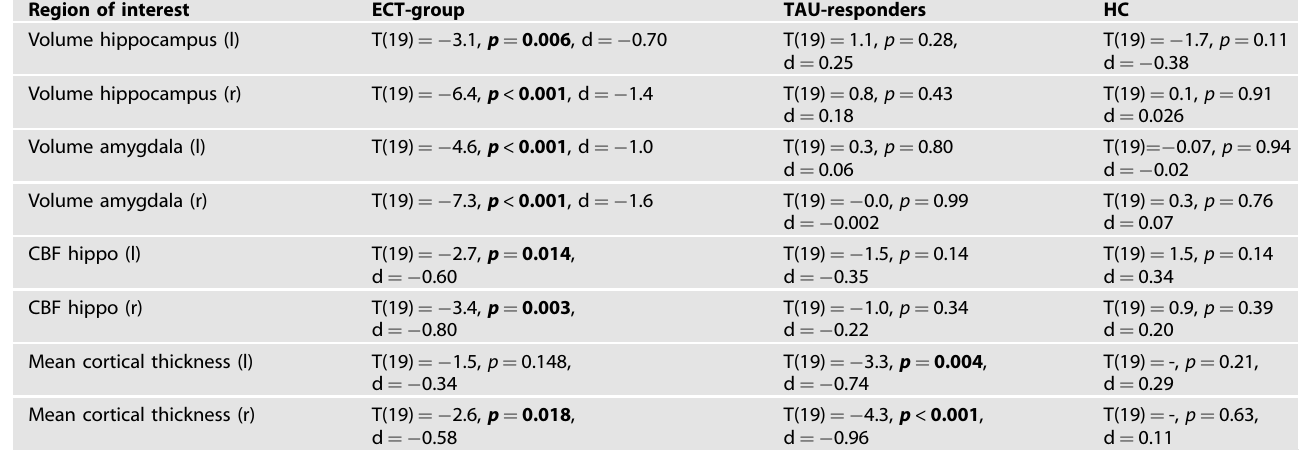
Table 2. Follow up paired t -tests for post hoc ANCOVAs with signi fi cant group × time